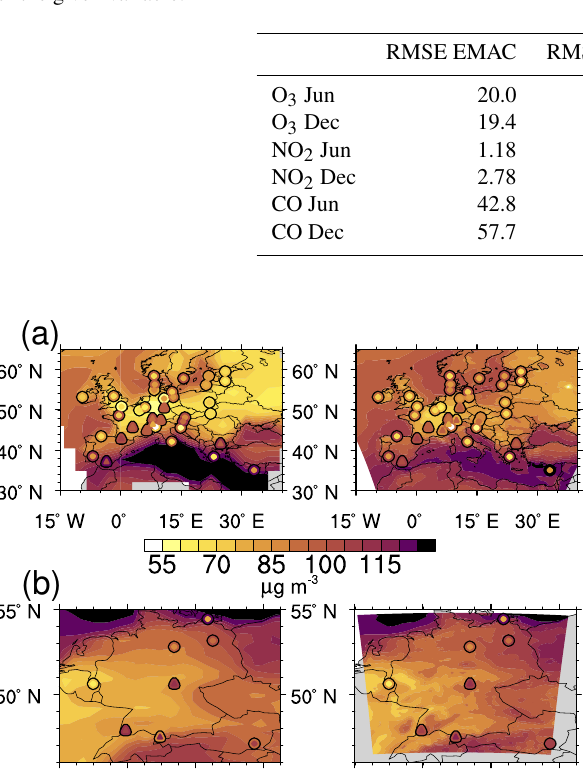
Table 2. Root mean square error (RMSE, in µgm − 3 for O 3 and NO 2 , in nmol mol − 1 for CO) and normalised mean bias error (MBE, in %) for EMAC and CM50 in comparison to ground-level observations. Shown are the values for June and December 2008. For the comparison, the height-corrected values are always used. The values are calculated from the monthly averaged values for all stations with observations for the given variable.